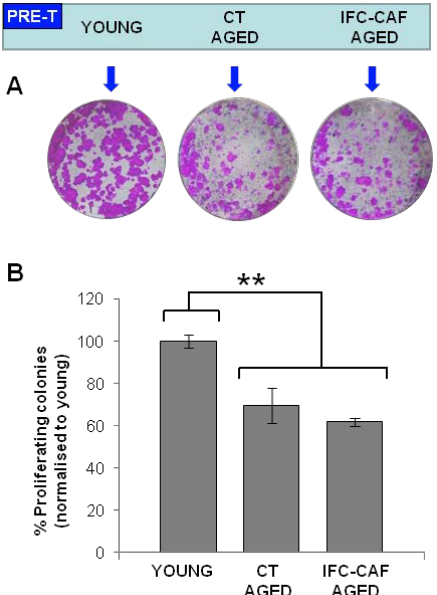
Figure 5. IFC-CAF ® does not rescue replicative decline of epidermal stem cells. ( A ) Representative clonogenicity assays with young keratinocytes or keratinocytes that were aged for 24 days in the presence or absence of 0.9mg/mL IFC-CAF ® as indicated (PRE-T), then plated in the absence of the compound. ( B ) Proportion of proliferative colonies (normalised to young keratinocytes) across the indicated conditions from two independent experiments with duplicate samples. Statistical signif- icance was assessed by Student´s t test (**: p < 0.01).